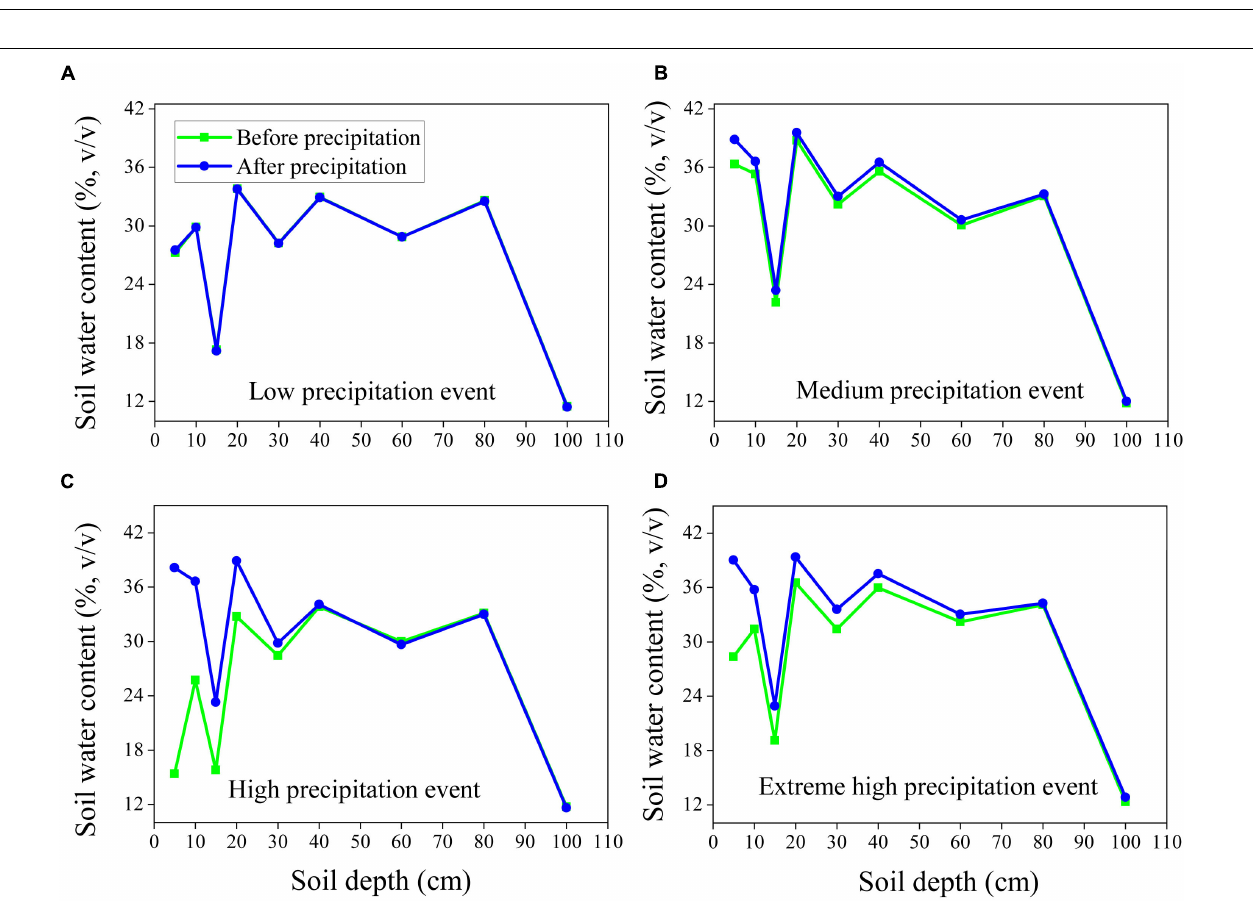
FIGURE 7 | The depth of soil water infiltration of alpine meadow at low precipitation event (A) , medium precipitation event (B) , high-precipitation event (C) and extremely high-precipitation event (D) .